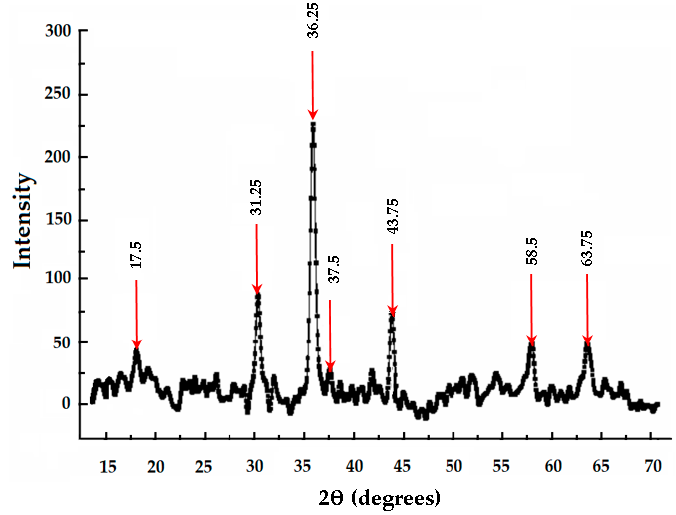
Figure 13. X-ray di ff raction results for the 1st sample of cobalt ferrite particle tailoring. Figure 13. X-ray diffraction results for the 1st sample of cobalt ferrite particle tailoring.